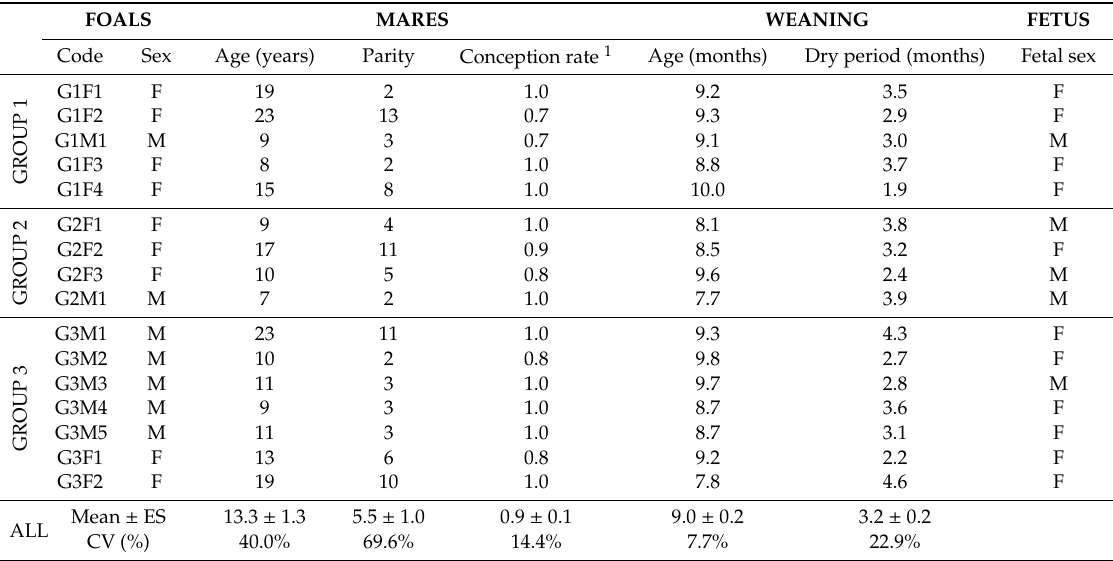
Table 2. Foals age at weaning, duration of the dry period and potential factors of variation. FOALS MARES WEANING FETUS Code Parity